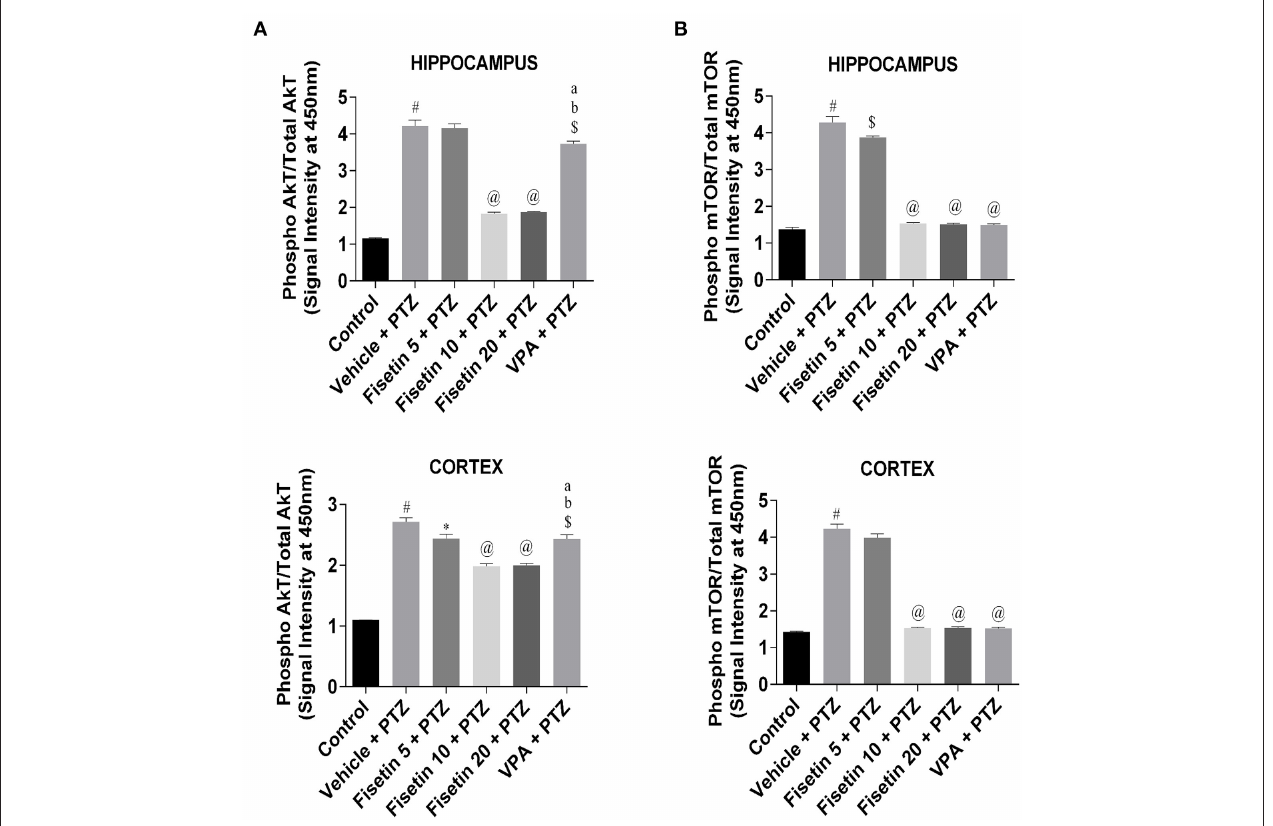
FIGURE 7 | Effect of fisetin administration on AkT/mTOR phosphorylation in kindled mice. Phosphorylation of AkT and mTOR was measured by phosphorylation ELISA. (A) Phosphorylation of AkT in hippocampus and cortex. (B) Phosphorylation of mTOR in hippocampus and cortex. Compared with the control group, the phosphorylation of AkT and mTOR was increased in vehicle + PTZ group. PTZ-induced activation of AkT/mTOR was suppressed by fisetin administration in a dose-dependent manner. Data were analyzed by one-way ANOVA followed by Tukey’s multiple comparison test ( n = 6) and expressed as mean ± SEM. # p < 0.001 as compared with control; * p < 0.05 as compared with vehicle + PTZ group; $ p < 0.01 as compared with vehicle + PTZ group; @ p < 0.001 as compared with vehicle + PTZ group a p < 0.001 as compared with fisetin 10 + PTZ group, and b p < 0.001 as compared with fisetin 20 + PTZ